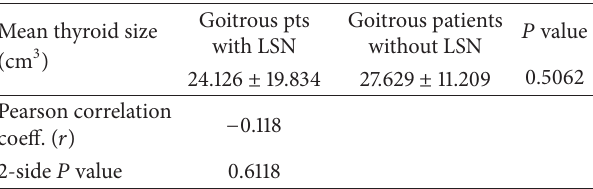
Table 3: Results of Fisher exact test and Pearson correlation test for association between thyroid size and LSN prevalence, no significant 𝑃